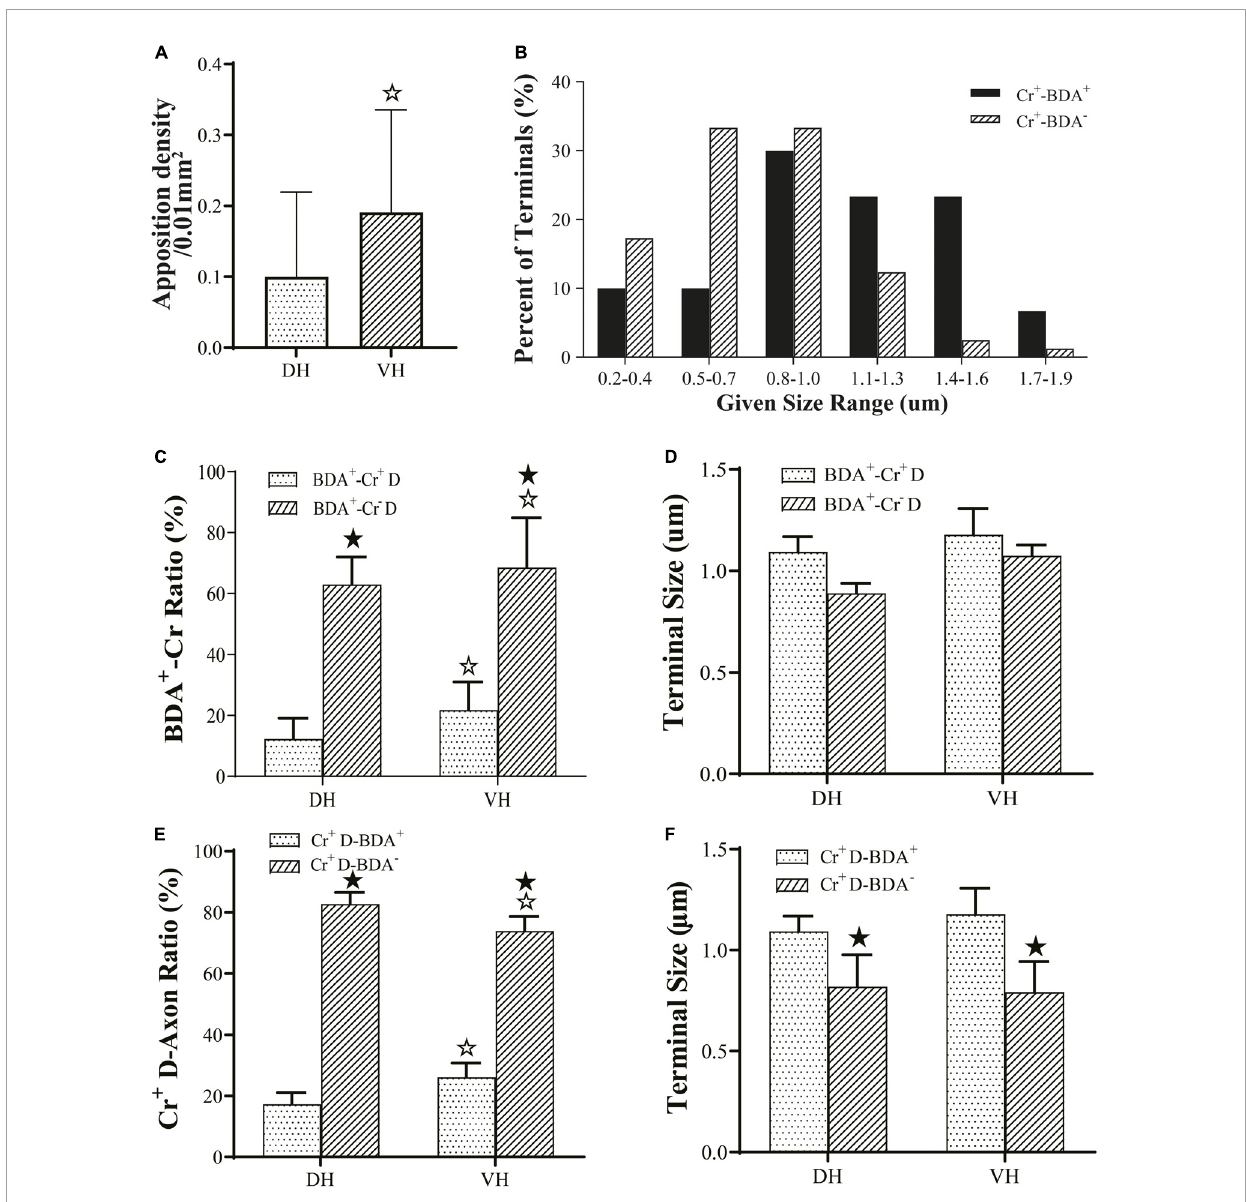
FIGURE5 Connection characteristics between fibers from the M1 region and CR+ neurons of the cervical spine. Histogram (A) shows the density of apposition points between biotinylated dextran amine (BDA+) fibers, Cr+ neurons and synaptophysin-positive (syn1+) structures. Histogram (B) shows the size-frequency distributions of BDA+ and BDA − terminals received by Cr+ dendrites for immuno-electron microscope (EM) experiments. The BDA+ terminals received by Cr+ dendrites mainly ranged in size from 0.8 to 1.6 µ m, and the BDA- terminals received by Cr+ dendrites ranged in size from 0.2 to 1.0 µ m range. Histogram (C) shows the ratio of synaptic connections formed by BDA+ terminals and the dendrites of interneurons. Histogram (D) showed the size of synaptic connections formed by BDA+ terminals and the dendrites of interneurons. Histogram (E) shows the ratio of synaptic connections formed by the dendrites of Cr+ neurons and axon terminals. Histogram (F) shows the size of synaptic connections formed by axon terminals and Cr+ interneurons. In the above panels, the DH and VH were short of the dorsal horn and the ventral horn. Cr + / − D, dendrite of Cr+ or Cr- neurons; P < 0.05, compared between the Cr+-BDA+ group and the Cr+-BDA-group; P < 0.05, compared between DH and